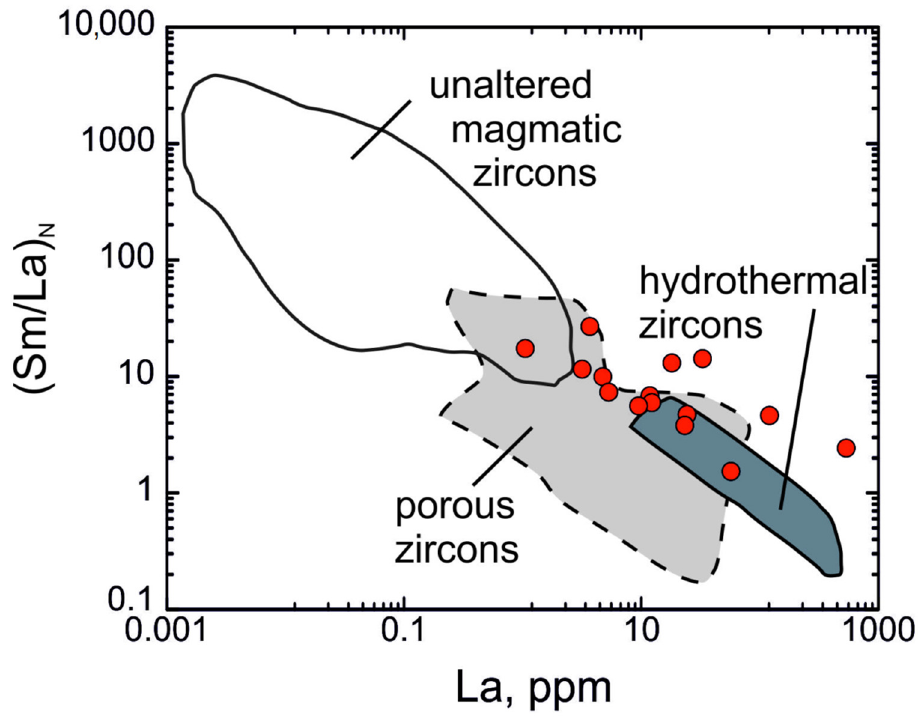
Figure 8. Co-variation diagrams showing the composition of the studied zircons. Fields are after [44–46].